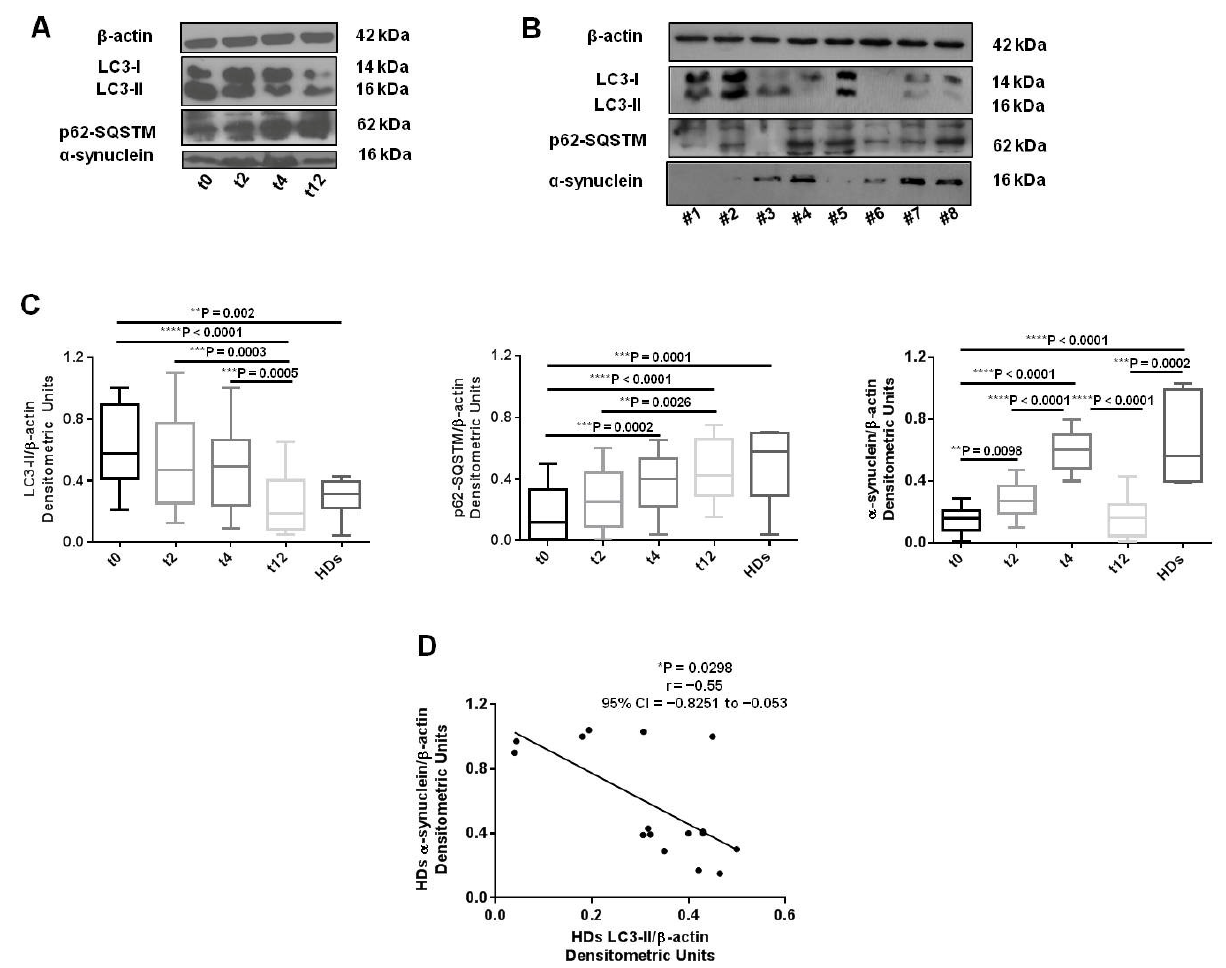
Figure 1. Belimumab decreases autophagy levels in PBMCs from SLE patients. ( A ) Western blot analysis of LC3-II, p62-SQSTM, and α -synuclein in lysates from SLE patients’ PBMCs at basal level (t0) and after 2, 4, and 12 weeks (t2, t4 and t12) of belimumab administration, and ( B ) from healthy donors (HDs). Results from a blot in a representative experiment are shown. ( C ) Densitometric analysis of SLE patients’ and HDs’ LC3-II (left panel), p62-SQSTM (middle panel), and α -synuclein (right panel) levels relative to β -actin, represented as the mean ± standard deviation (SD). In SLE: for LC3-II, **** p < 0.0001 t0 vs. t12, *** p = 0.0003 t2 vs. t12, *** p = 0.0005 t4 vs. t12; for p62-SQSTM, *** p = 0.0002 t0 vs. t4, **** p < 0.0001 t0 vs. t12, ** p = 0.0026 t2 vs. t12; for α -synuclein, ** p = 0.0098 t0 vs. t2, **** p < 0.0001 t0 vs. t4, t2 vs. t4, and t4 vs. t12. HDs’ mean LC3-II and p62-SQSTM expression levels are comparable to those of SLE patients at t12, and opposite (lower or higher, depending on the single marker trend) to SLE at baseline (t0) (** p = 0.002 for LC3-II, *** p = 0.0001 for p62-SQSTM, **** p < 0.0001 for α -synuclein). Only for α -synuclein, HDs’ expression levels are comparable to those of SLE patients at t4, given the dramatic decrease in levels observed at t12 (*** p = 0.0002 SLE t12 vs. HDs). ( D ) Correlation and linear regression analysis of α -synuclein and LC3-II levels relative to β -actin in HDs (* p = 0.0298, r= − 0.55, 95% confidence interval (CI) = − 0.8251 to − 0.053). HDs’ PBMCs showed interindividual variability for the autophagy markers (Figure 1B,C) and, in particular, α -syn and LC3-II levels displayed an inverse significant correlation (Figure 1D; * p = 0.0298, r= − 0.55, 95% confidence interval (CI) = − 0.8251 to − 0.053). HDs’ PBMCs displayed lower LC3-II and higher p62 expression levels in comparison with SLE patients’ PBMCs, both at baseline (LC3-II: ** p = 0.002 SLE t0 vs. HDs; p62: *** p = 0.0001 SLE t0 vs. HDs) and after BLM administration up to week 12, at which point autophagy markers’ mean levels in SLE patients were similar to those of the